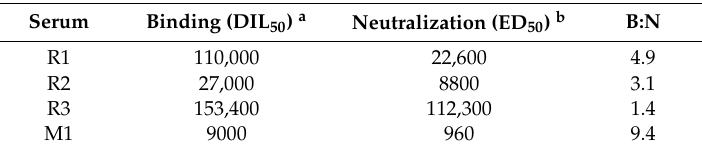
Table 1. Characteristics of antiabrin antibodies.